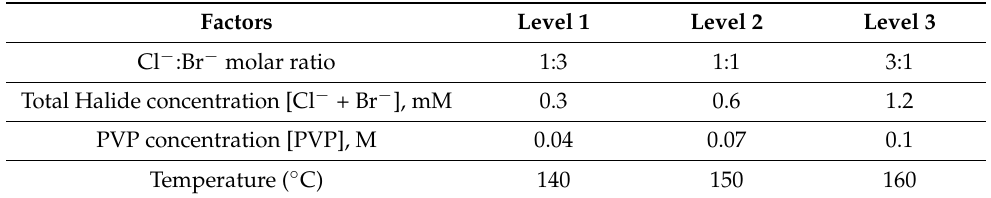
Table 1. The Taguchi DOE with four factors at three